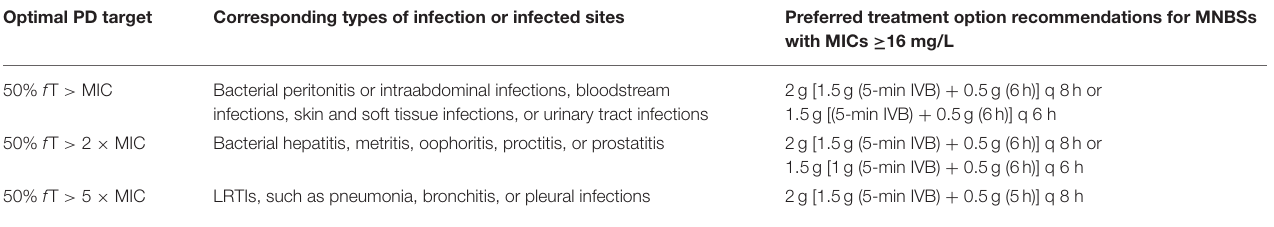
TABLE 4 | Summary of preferred treatment option recommendations in the empiric therapy of meropenem for different types of infection based on our analysis. Optimal PD